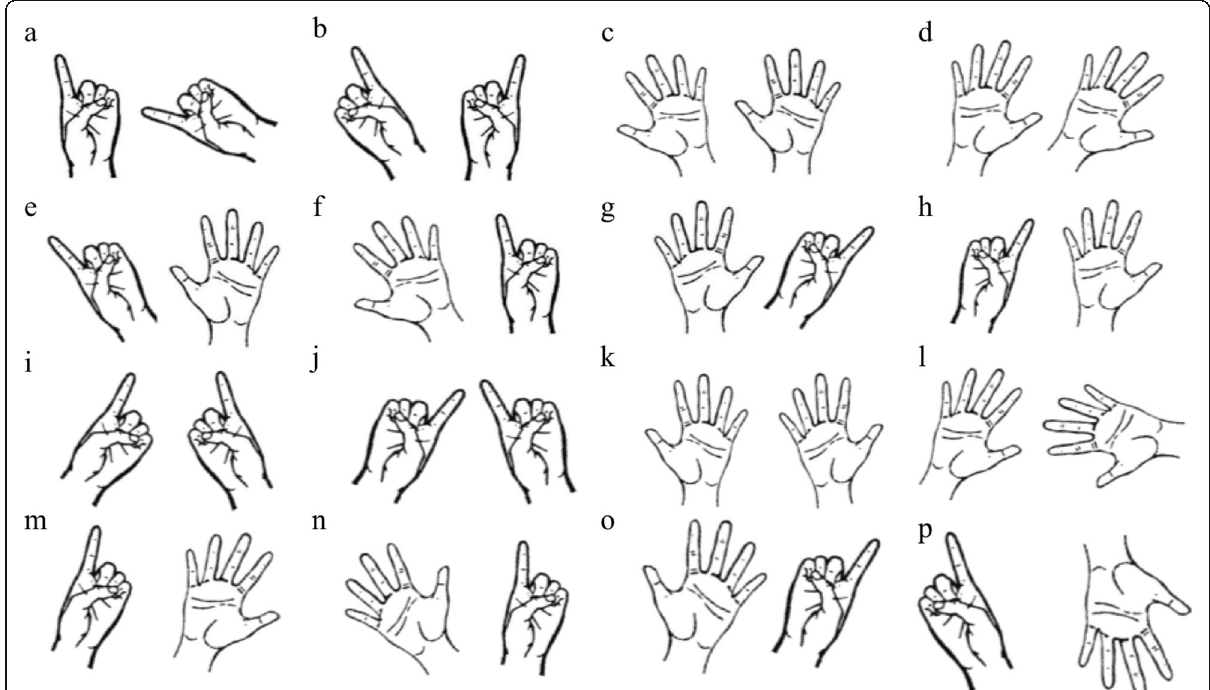
Fig. 2 All hand stimuli combinations. The same hand condition ( a – h ) includes ten pairs each, and the different hand condition includes ( i – p ) includes ten pairs